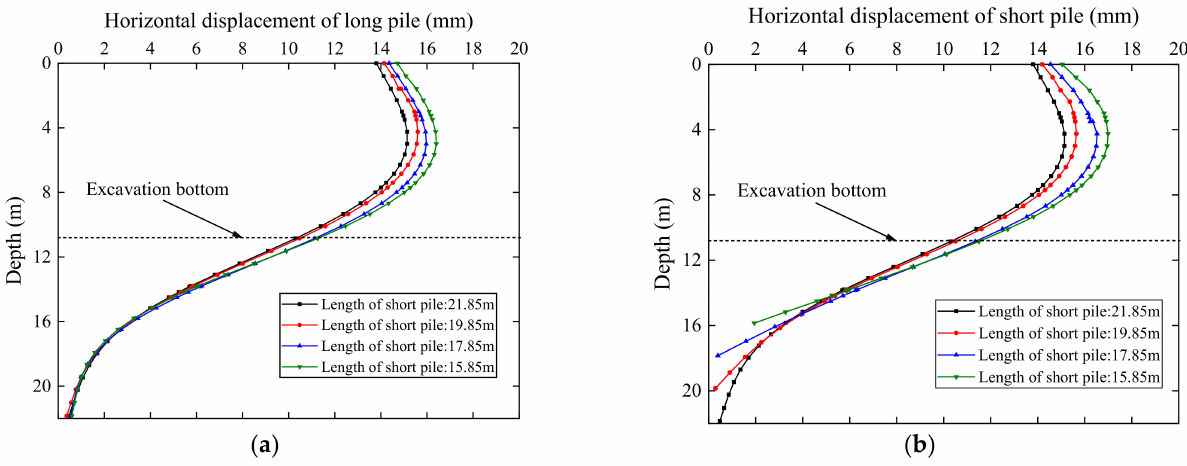
Figure 16. Horizontal displacement of piles under different short pile lengths: ( a ) long pile; ( b ) short